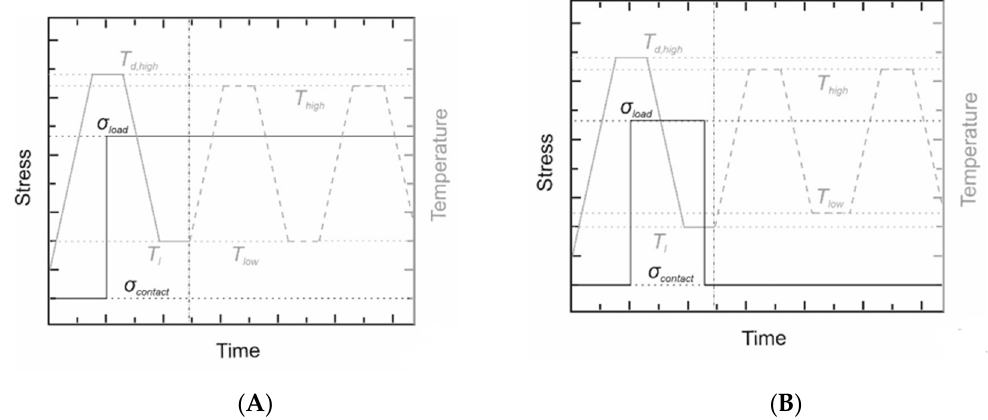
Figure 1. Thermomechanical investigation of PEUU foam to characterize bidirectional actuation under constant load ( A ) and load-free conditions ( B ). A vertical dotted line was inserted to illustrate the transition from programming to actuation.